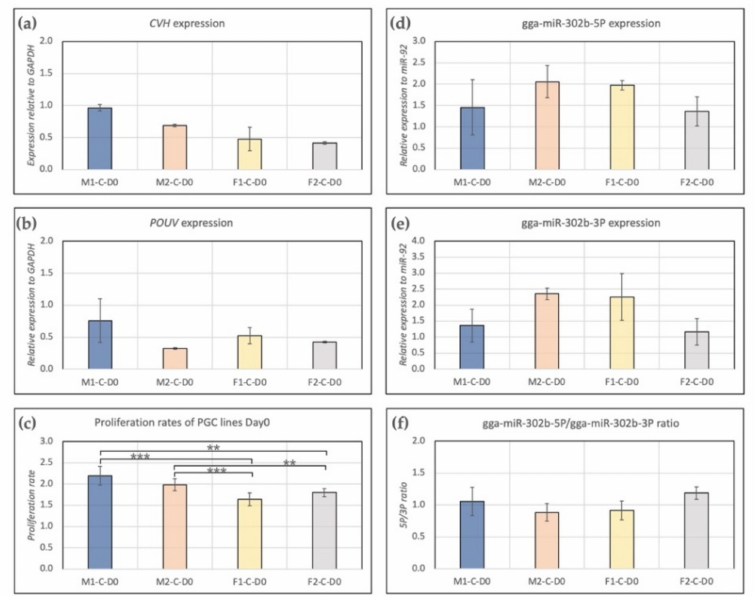
Figure 1. Characterization of PGC lines M1, M2, F1 and F2 on Day 0 of the experiments. Expression of CVH ( a ), POUV ( b ), gga-miR-302b-5P ( d ) and gga-miR-302b-3P ( e ) were analysed. GAPDH (in the case of CVH and POUV) and miR-92 (in the case of microRNAs) were used as housekeeping genes in the experiments. The proliferation rate ( c ) and 5P/3P ratio ( f ) for the PGC lines are also presented ( p < 0.01 **, p < 0.001 ***).